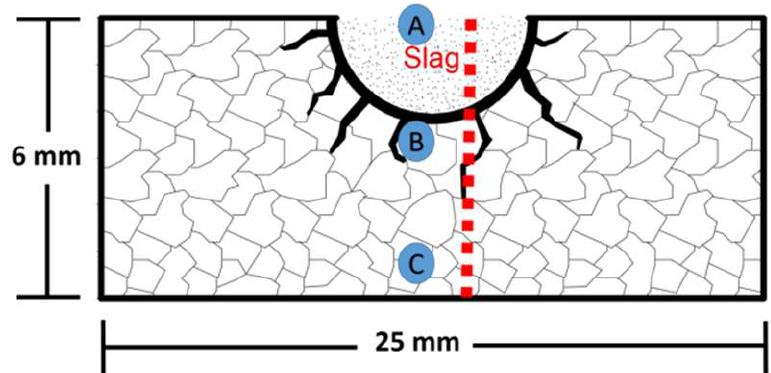
Figure 1. Scheme representing the chemical resistance test of silicomanganese slag on refractory samples where: A = slag zone, B = slag/refractory interface, and C = refractory zone.